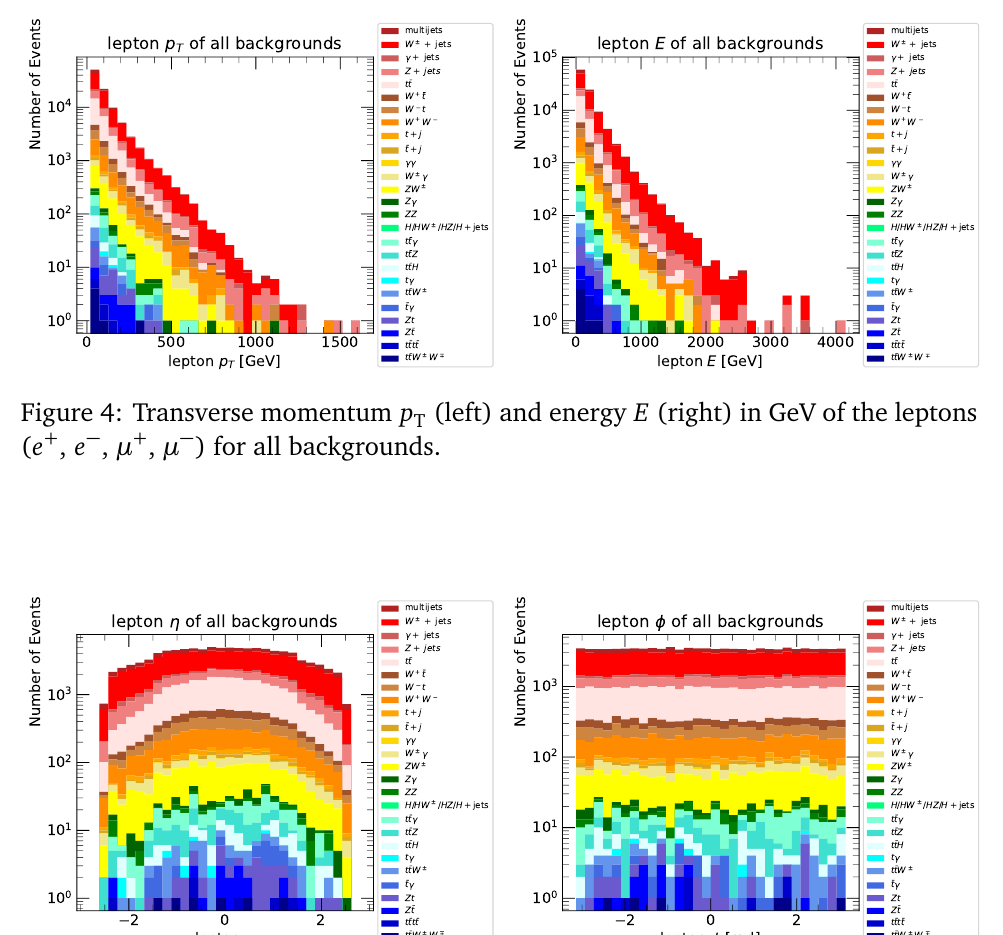
Figure 5: Pseudorapidity η (left) and azimuthal angle φ (right) of the leptons ( e + , e − , µ + , µ − ) for all